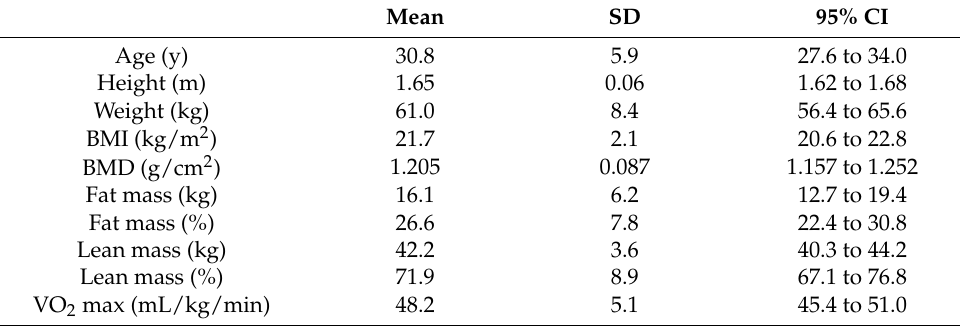
Table 1. Characteristics of the participants ( n =